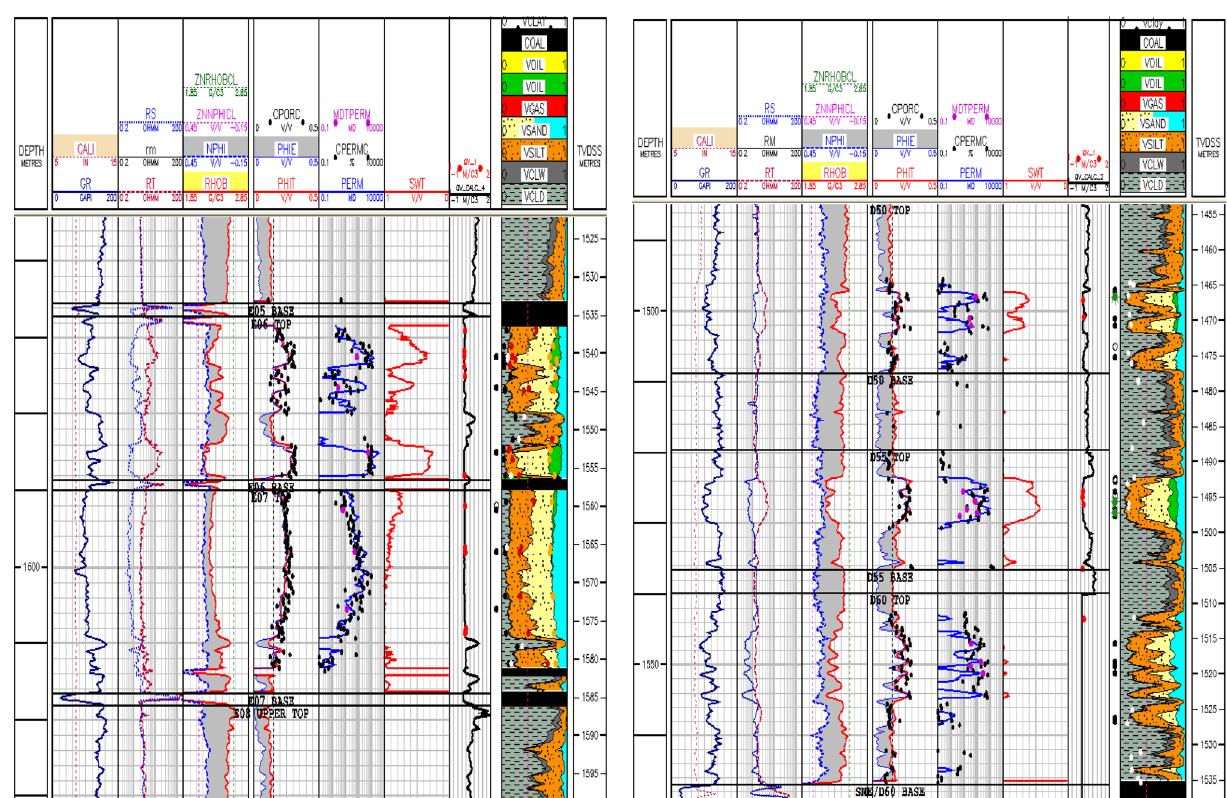
Fig. 5 Petrophysical log match of permeability for clean and laminated zones